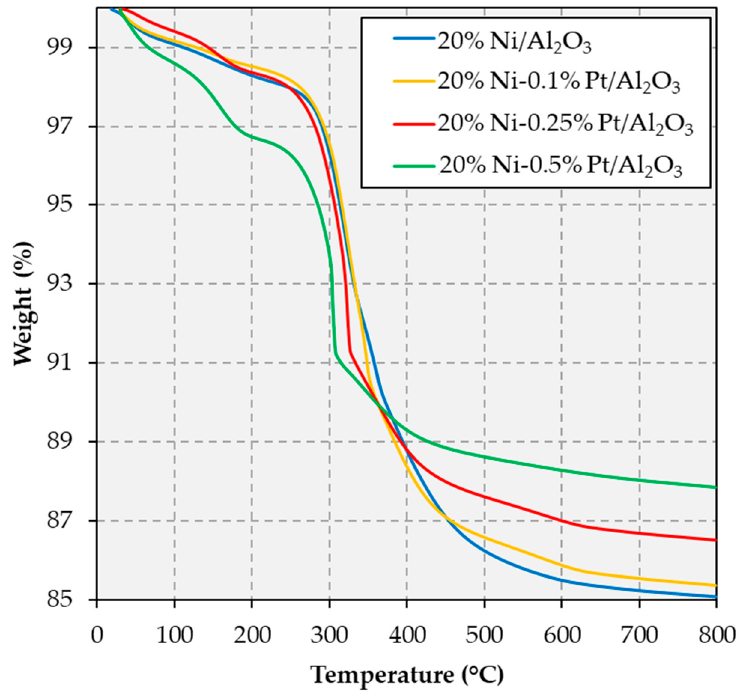
Figure 7. Thermogravimetric analysis of the spent catalysts recovered from deoxygenation experiments.